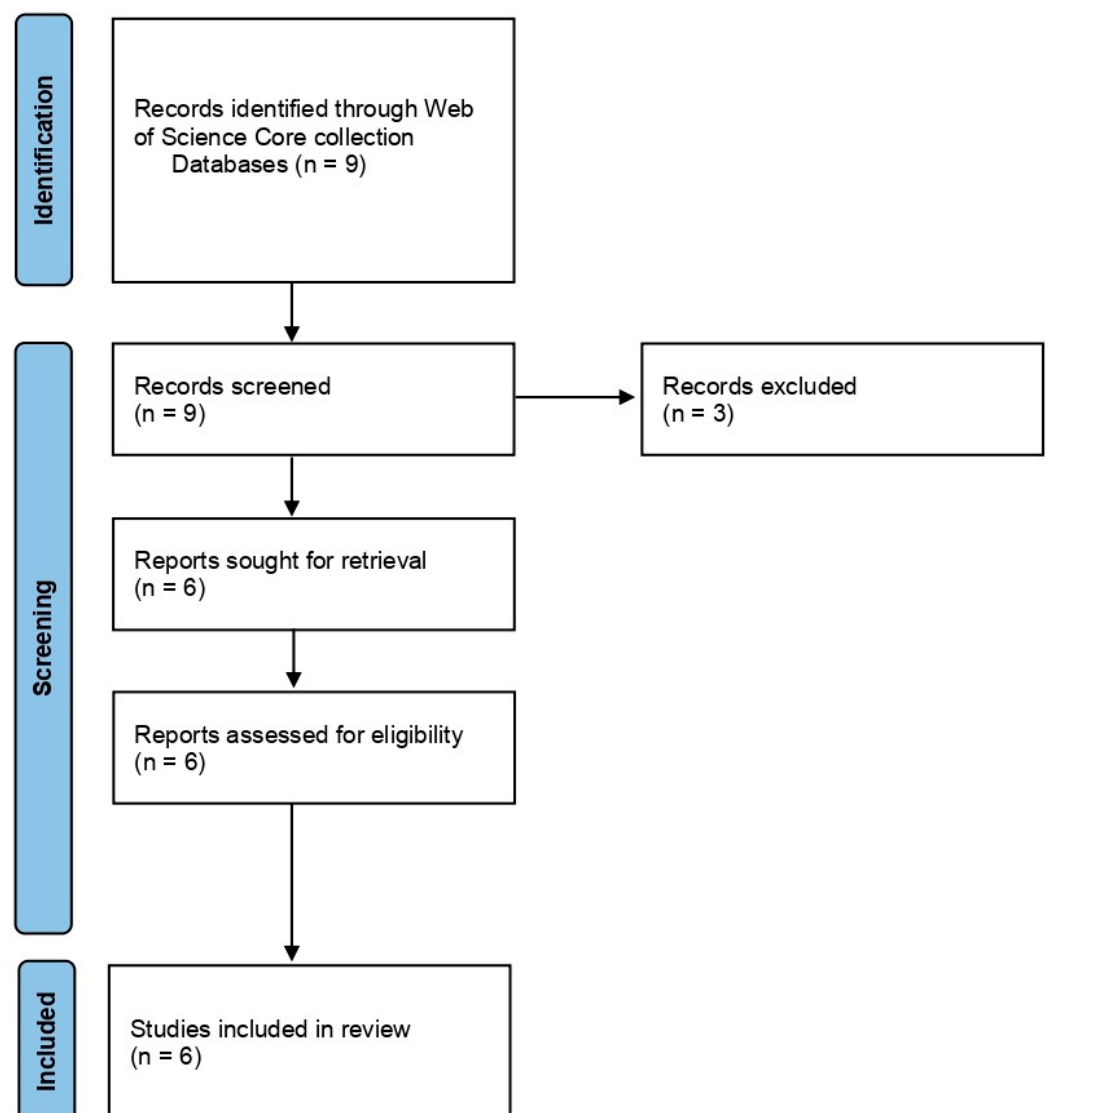
Figure 3. PRISMA flowchart summarizing the sequence of information gathering and selection for the systematic review of Group 2: Effect of NTP/cold plasma on degradation/decontamination of DON mycotoxin .